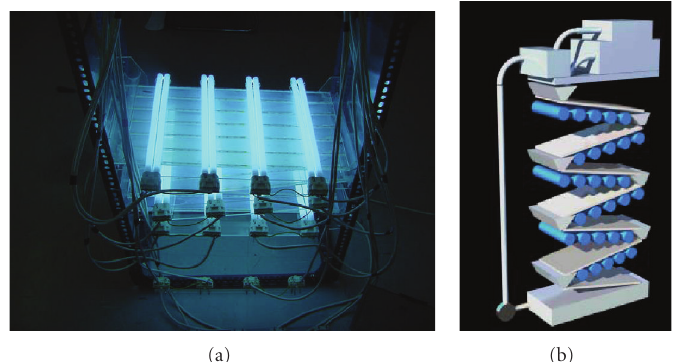
Figure 2: Multiple thin film plate reactor stack (a) lab-based unit, (b) concept design for scaled-up unit.